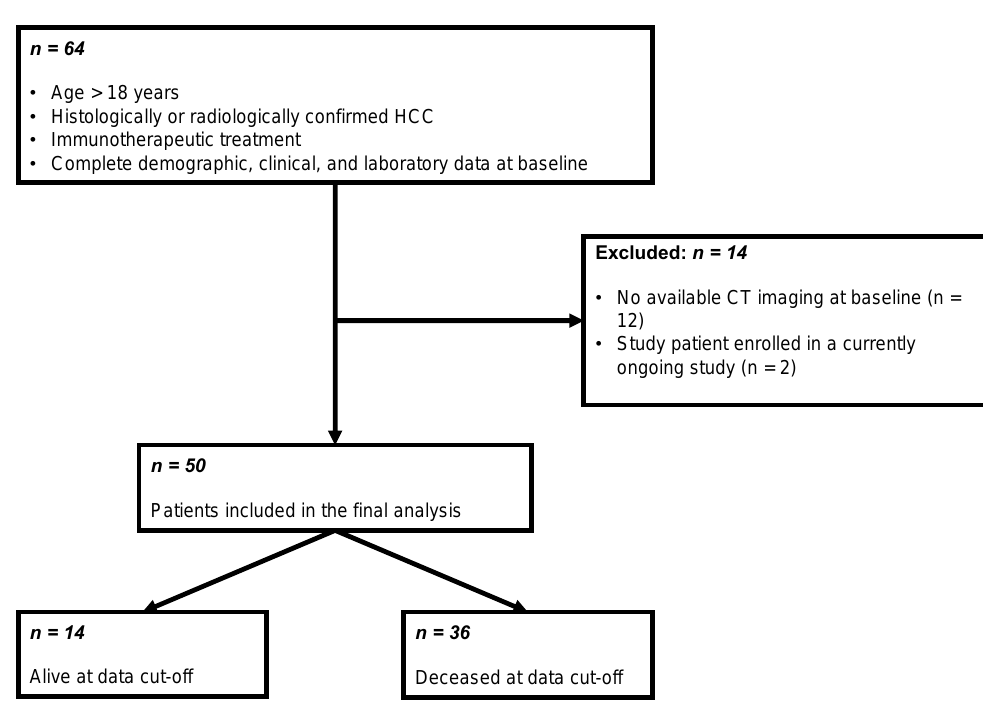
Figure 1. Flowchart of the patient selection process for this study.